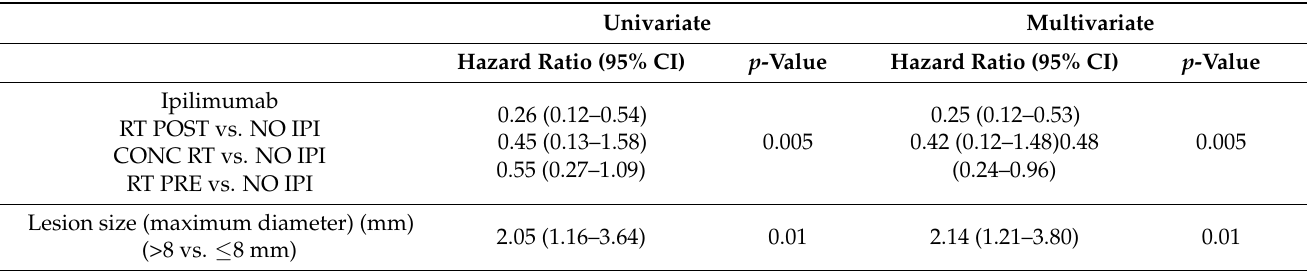
Table 5. Univariate and multivariate analysis for local control of the treated lesions.